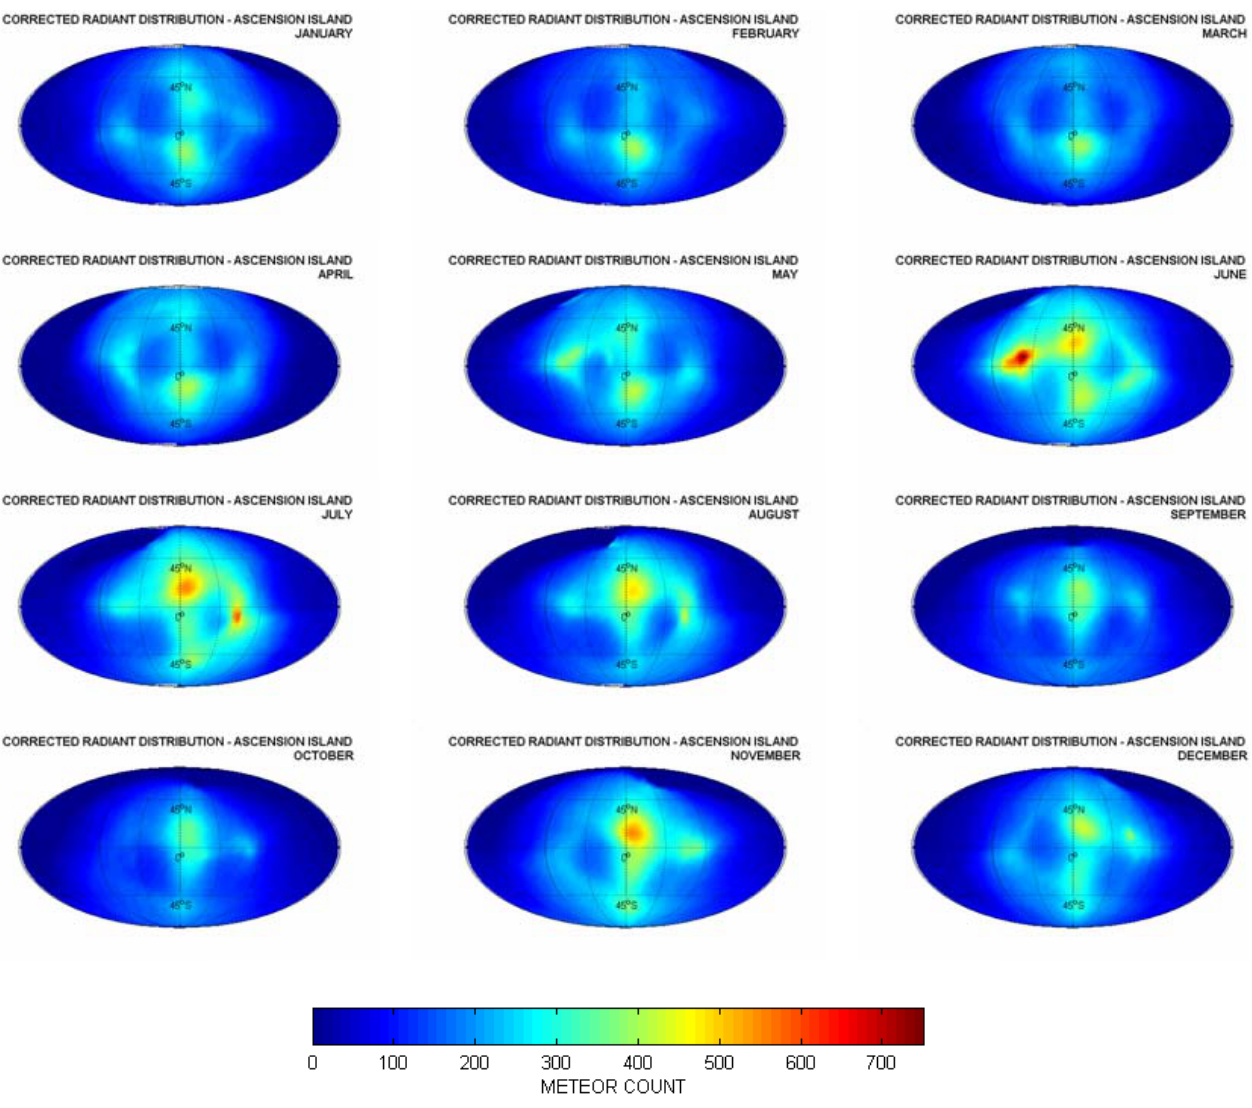
Fig. 5. The radiant distribution of all meteors observed at Ascension Island in the interval January 2005 to December 2006. All figures are plotted in the Ecliptic coordinate frame to avoid longitudinal motion of the source regions throughout the year. Contours are based upon meteor counts in 4 ◦ by 4 ◦ latitude/longitude